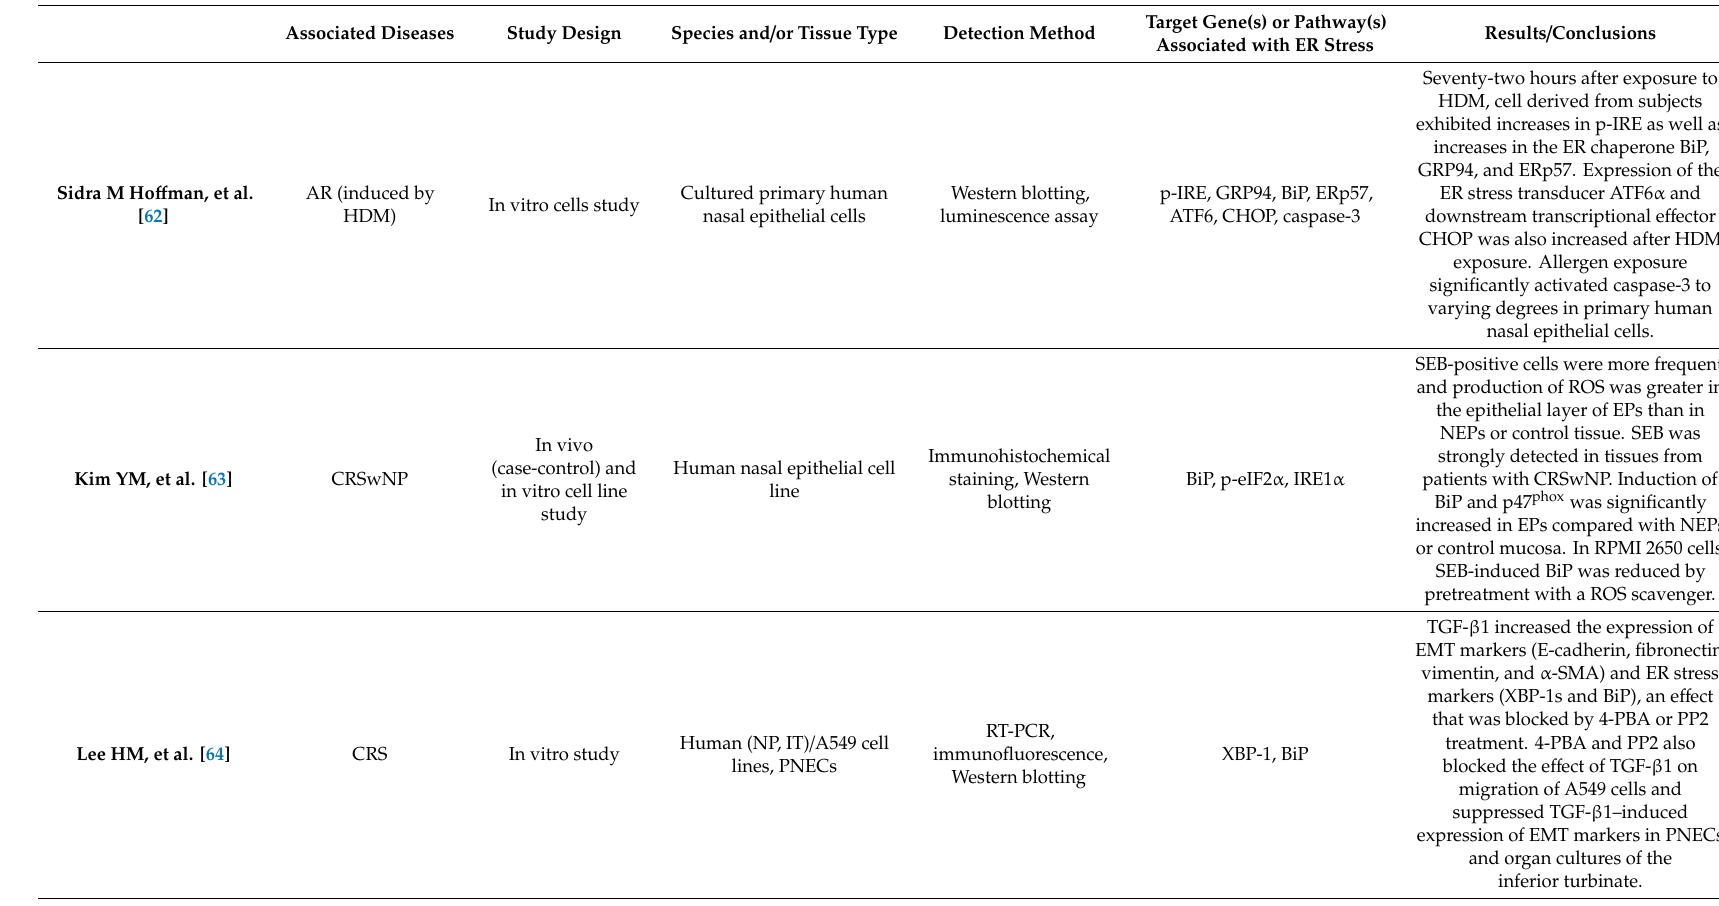
Table 2. Studies assessing the association between rhinologic diseases and ER